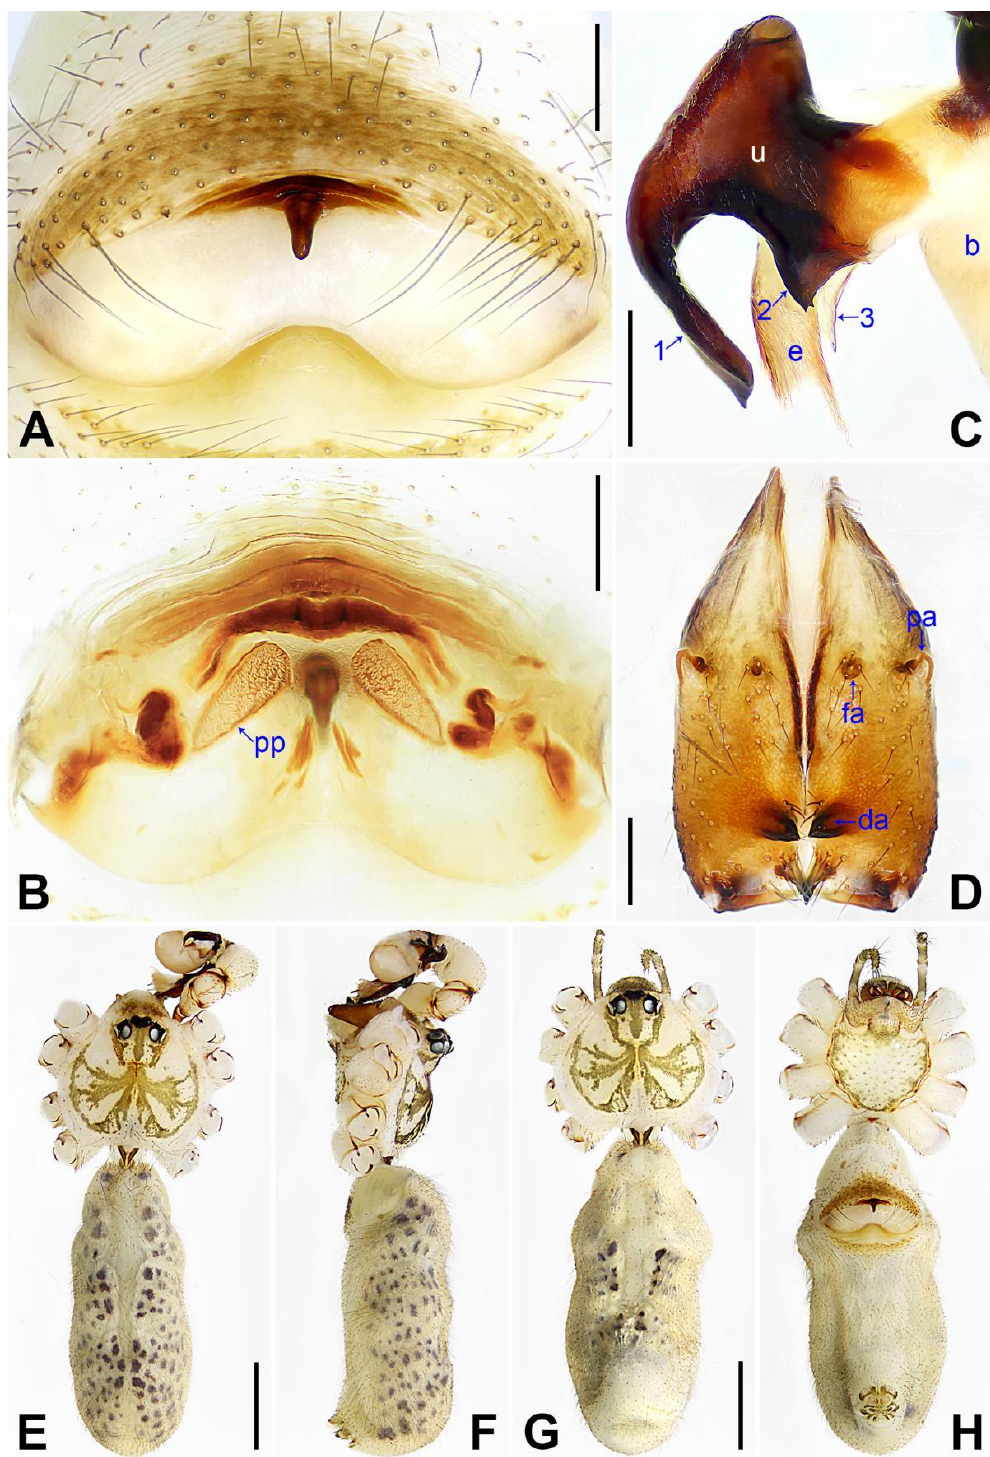
Figure 8. Pholcus lishi sp. nov., holotype male ( C – F ) and paratype female ( A , B , G , H ): ( A ) epigyne, ventral view; ( B ) vulva, dorsal view; ( C ) bulbal apophyses, prolateral view (arrow 1 points at curved distal apophysis, arrow 2 points at angular proximal apophysis, arrow 3 points at “pseudo-appendix”); ( D ) chelicerae, frontal view; ( E ), ( G ) habitus, dorsal view; ( F ) habitus, lateral view; ( H ) habitus, ventral view. da = distal apophysis, e = embolus, fa = frontal apophysis, pa = proximo–lateral apophysis, pp = pore plate, u = uncus. Scale bars: ( A – D ) = 0.20 mm; ( E – H ) = 1.00 mm.